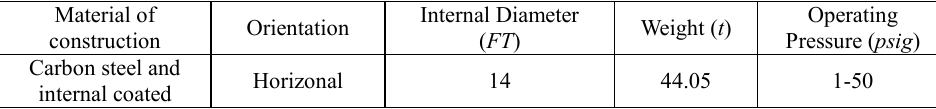
Table 2. Technical characteristics of closed drain collection drum.